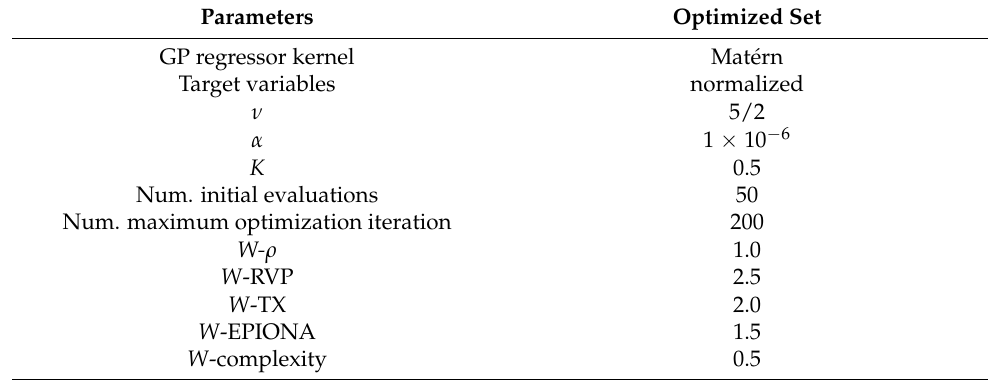
Table 4. List of the optimized hyperparameters of the Bayesian algorithm and user setting parameters.